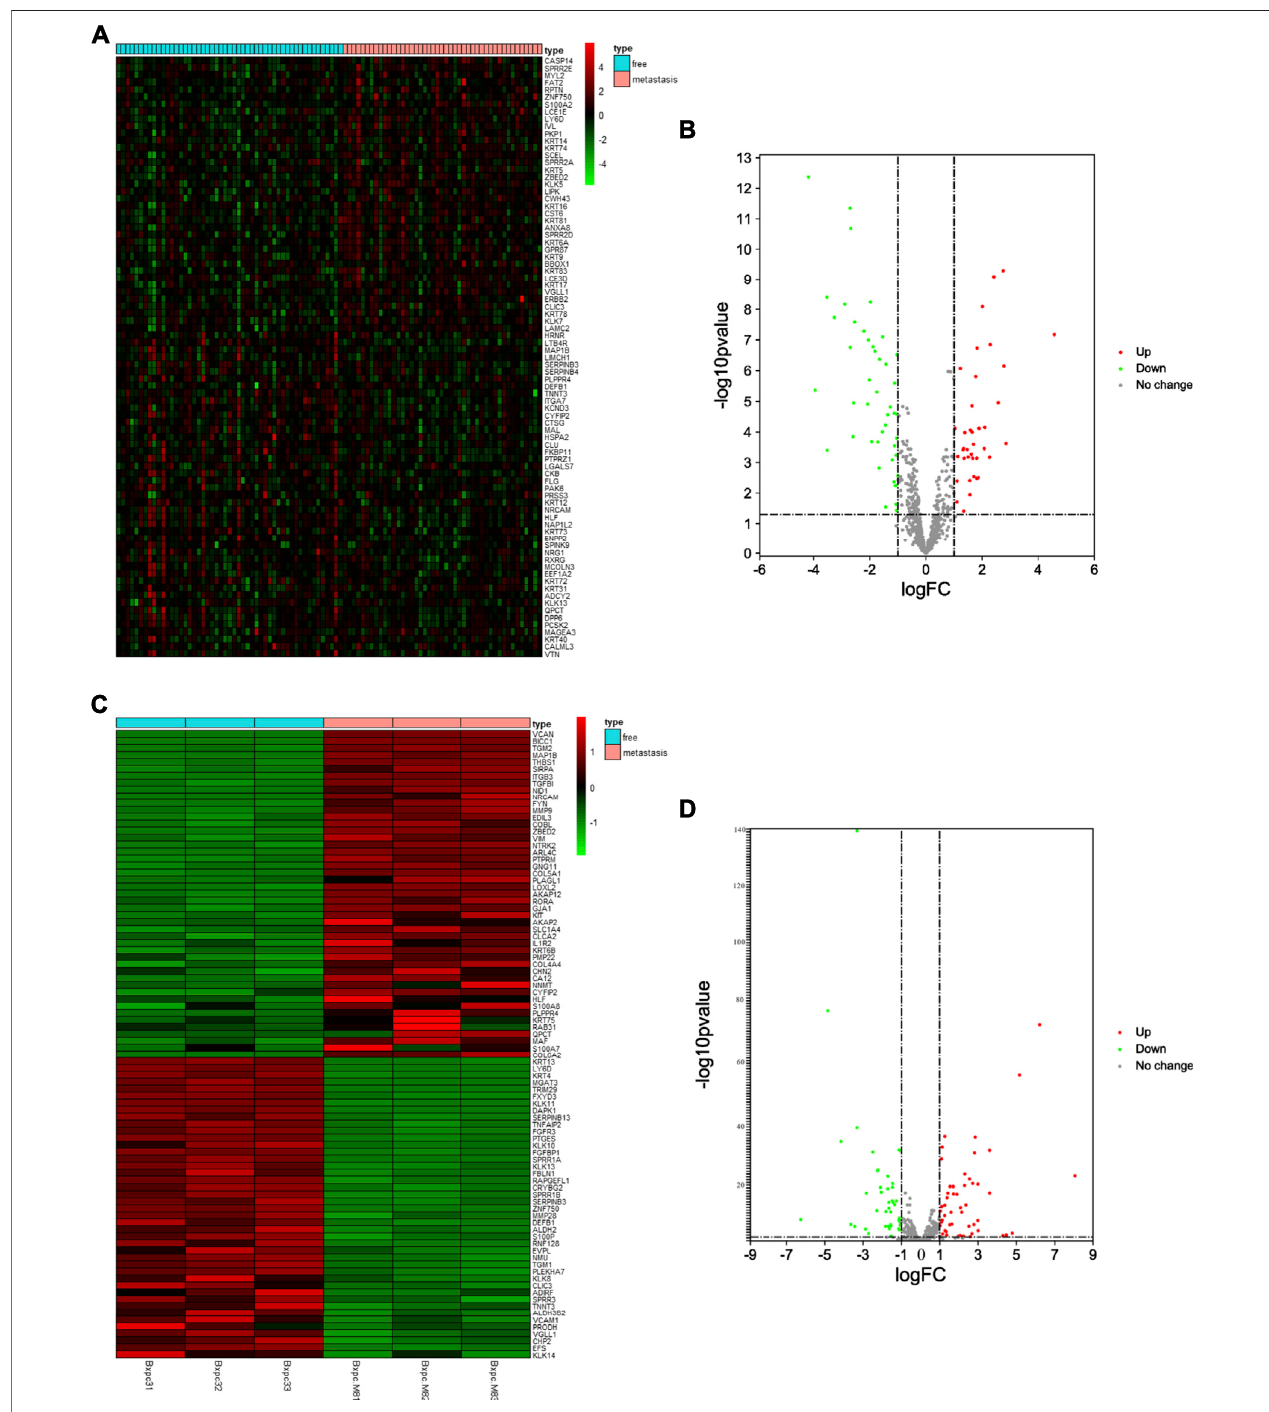
FIGURE 2 | Identi fi cation of Differentially Expressed EMT-related Genes (A, C) The heat map of DEGs in pancreatic cancer from TCGA dataset and BxPC-3-M8 and BxPC-3 cells ( p -value < 0.05and |logFC| > 1).Red colorindicates up-regulatedgenes,and green indicates down-regulated genes (B,D) ThevolcanoplotofDEGs inpancreaticcancerfromTCGAdataset (B) andBxPC-3-M8andBxPC-3cells (D) .ThereddotsandgreendotsrepresentupregulatedDEGsanddownregulatedDEGs with signi fi cance ( p -value < 0.05 and |log FC| > 1), respectively. The gray dots are those DEGs without signi fi cance.